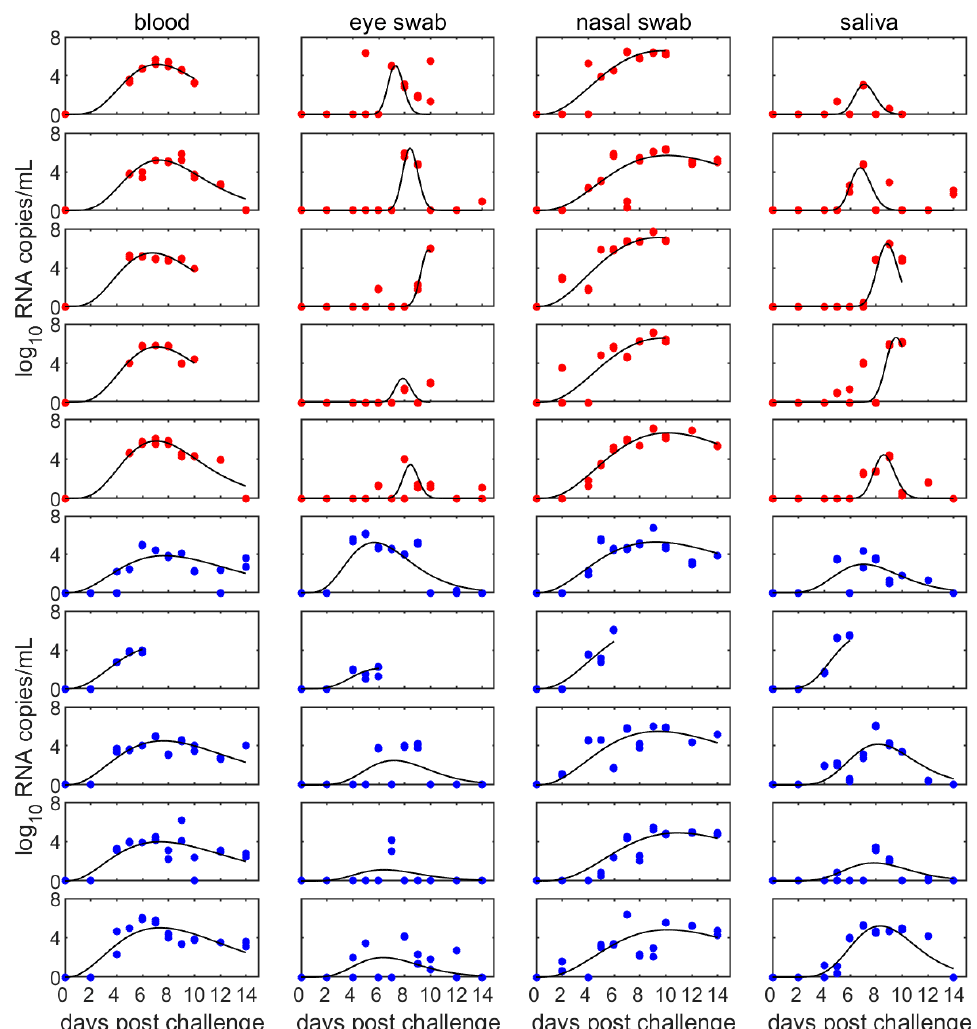
Figure 2. Levels (log 10 RNA copies/mL) of PPRV RNA in different samples types: blood (first column); eye swabs (second column); nasal swabs (third column); or saliva (fourth column). Results are shown for ten goats infected with either the Lineage-II/Ghana (top five rows; red symbols) or Lineage-IV/Morocco (bottom five rows; blue symbols) strain of PPRV. The circles are the observed levels of viral RNA and the black line is the fitted curve for the animal.